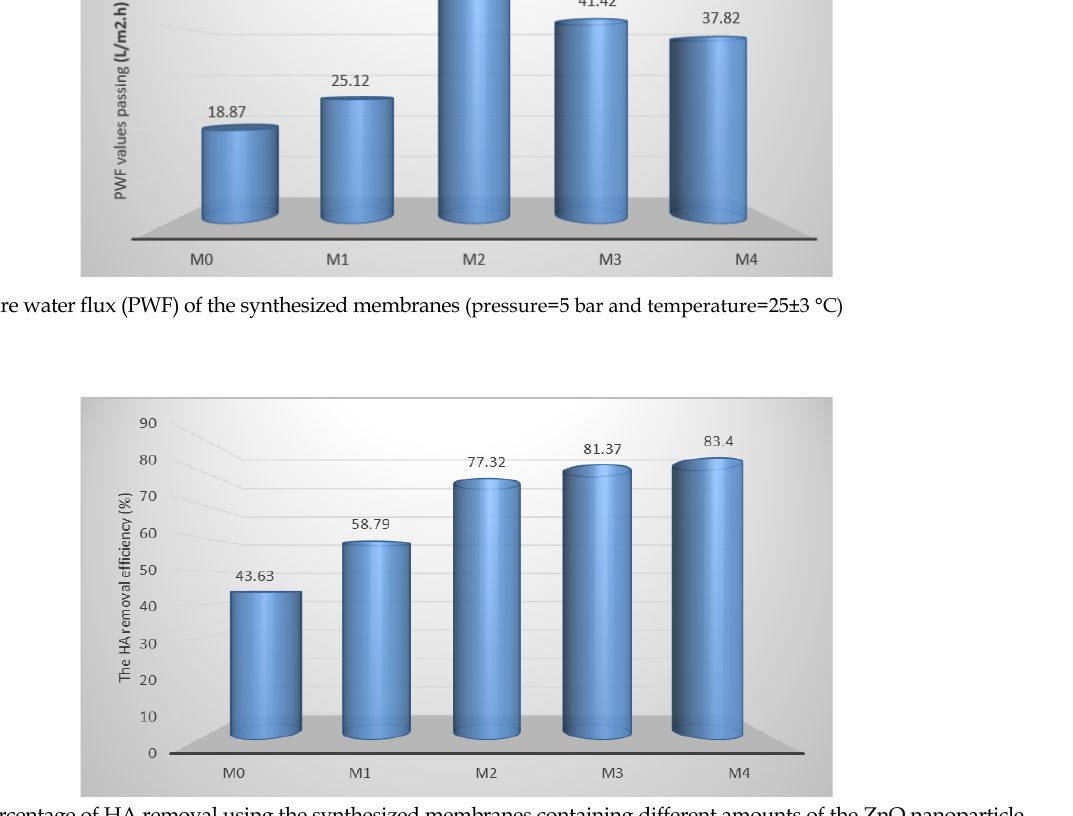
Rezaee et al. Nanohybrid Membrane Efficiency in NOM Removal From Water. J Adv Environ Health Res. 2022;